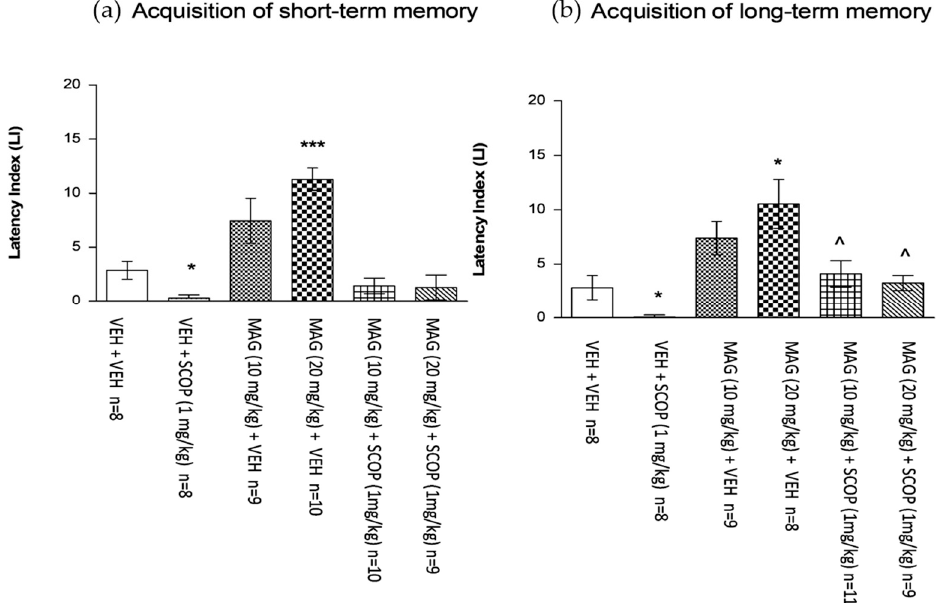
Figure 8. Influence of an acute administration of magnoflorine (MAG) on the memory impairment induced by an acute injection of scopolamine (SCOP), expressed as latency index (LI) during the short-term ( a ) or long-term ( b ) memory acquisition using the PA test in mice. A non-effective dose of MAG (10 mg/kg), effective dose of MAG (20 mg/kg) or vehicle were administered 15 min before vehicle or SCOP (1 mg/kg) injection. All drugs were administered 15 min before the first trial and animals were re-tested 2 h (for short-term memory) or 24 h (for long-term memory) later; n = 8–11; the means ± SEM; * p < 0.05; *** p < 0.001 vs. VEH/VEH-treated group; ˆ p < 0.05 vs. VEH/SCOP (1 mg/kg)-treated group; Tukey’s test.